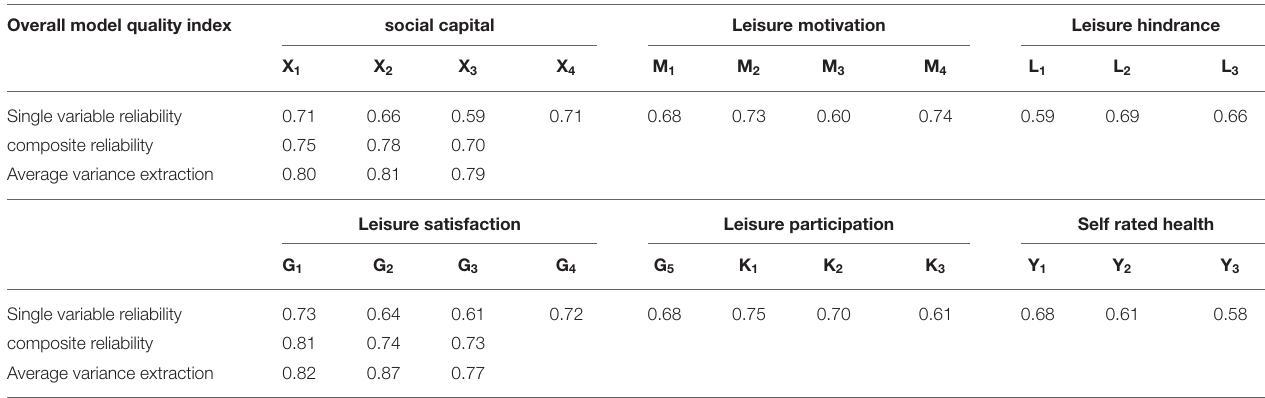
TABLE 3 | Parameter estimation and internal quality inspection statistics of the structural model validation analysis. Overall model quality index